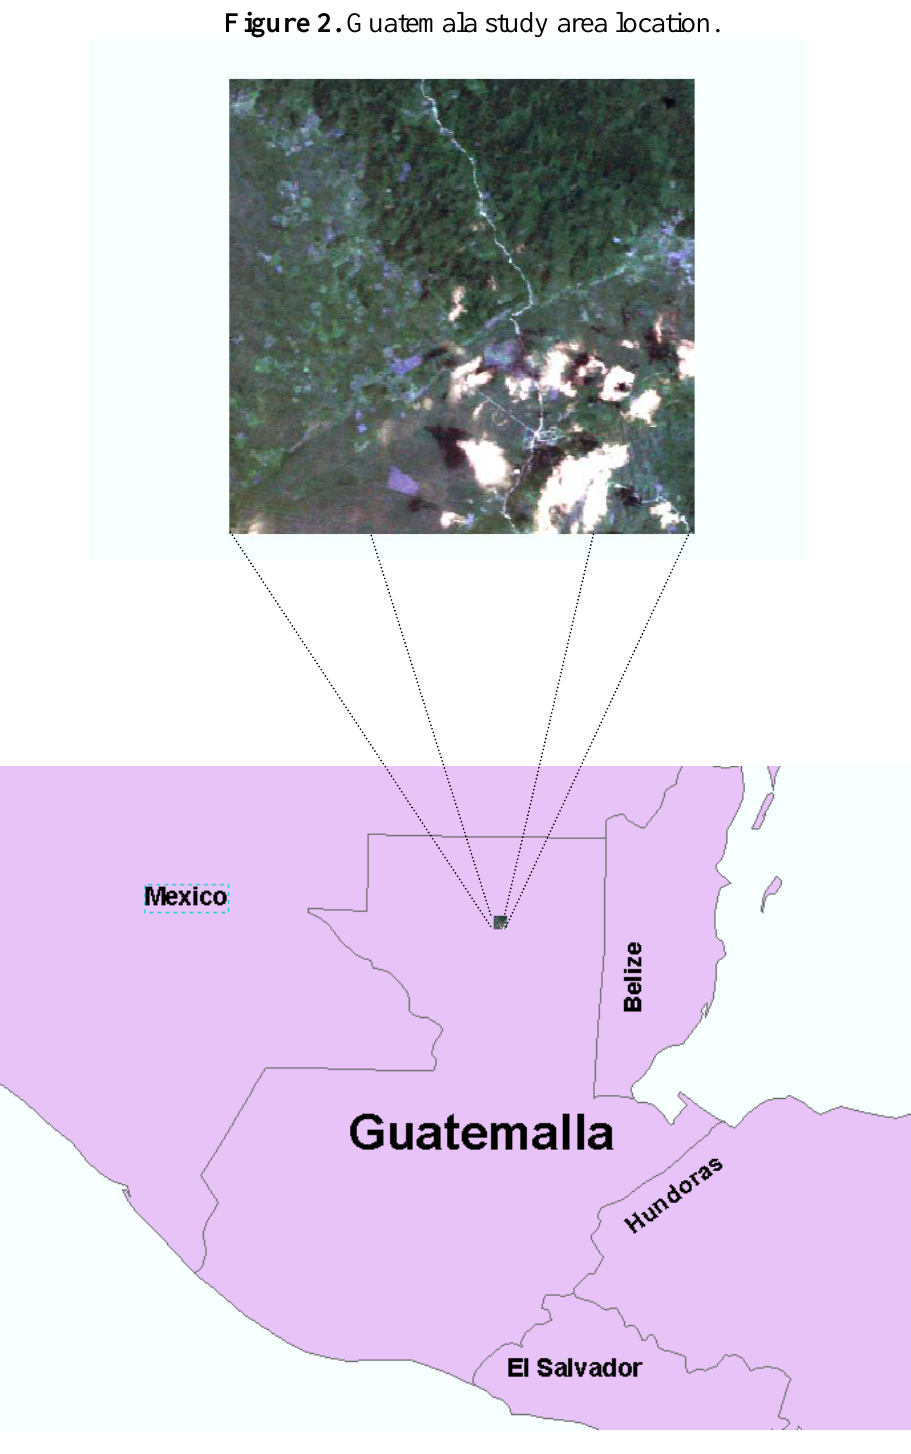
Figure 2. Guatemala study area